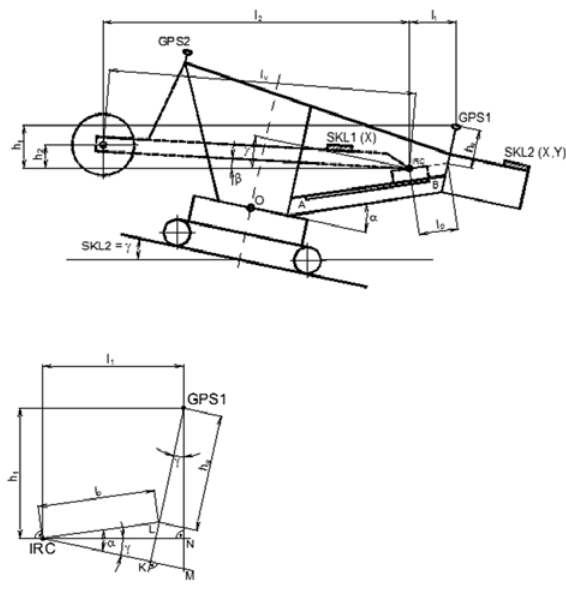
Fig. 9. Bucket wheel below horizontal plane sign β = sign γ